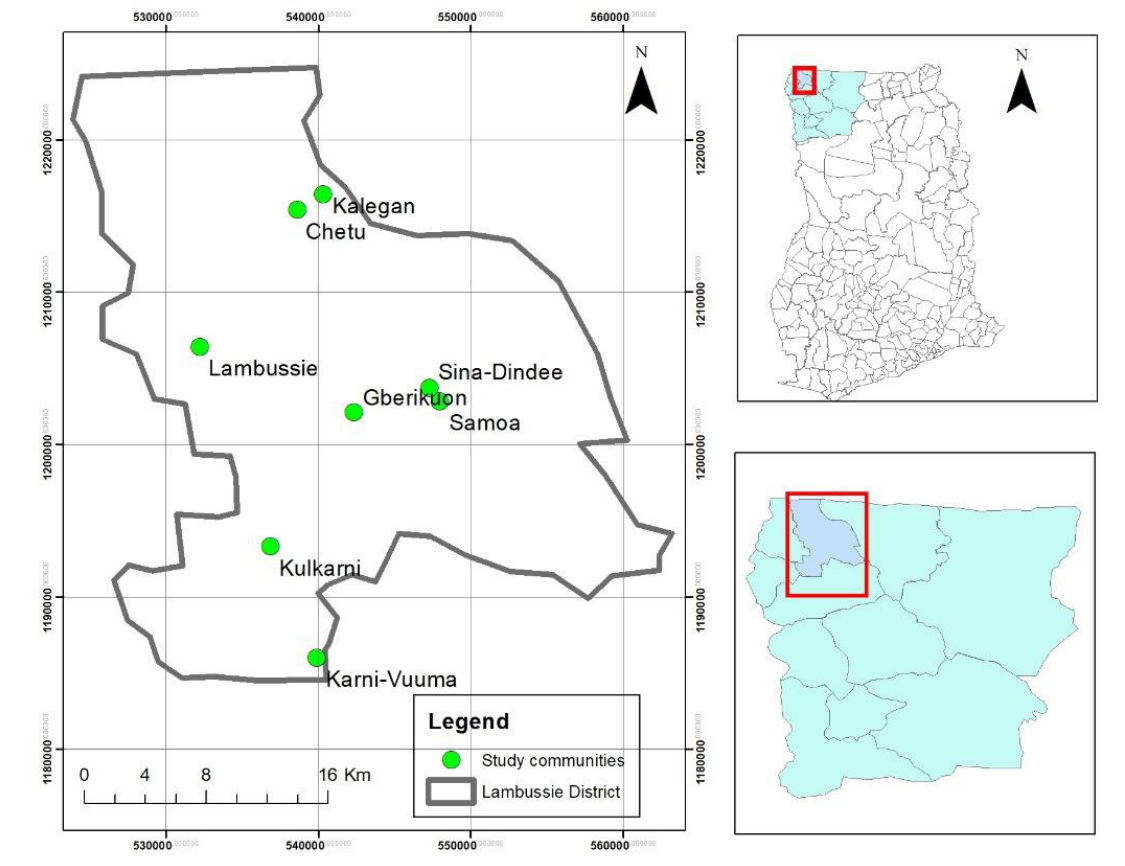
Figure 1: Lambussie District in regional and nationl context